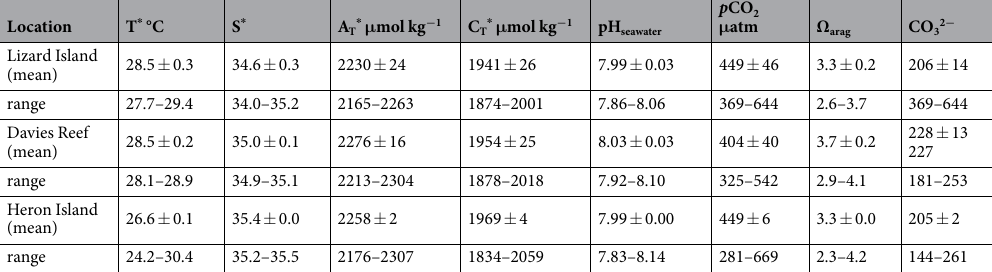
Table 2. Comparison of within-reef carbonate chemistry at Lizard Island (northern), Davies Reef (central) and Heron Island (southern) of the Great Barrier Reef. Values for Davies Reef and Heron Island determined by Albright et al . 33, 34 , respectively. Averages and ranges of measured * and calculated physical and chemical parameters given. Carbonate chemistry for Lizard Island was determined in this study in January 2014 on the back reef inside the Lizard Island lagoon (Fig. S1). Carbonate chemistry was determined on the back reef flat at Davies Reef in the summer January 2012. In Heron Island, values are for the combined sampling on the reef flat and crest in March 2012. T = temperature, S = salinity, A T = Total alkalinity, C T = Carbon total, p CO 2 = partial pressure of carbon dioxide, Ω arag = Aragonite saturation, CO 32 − = carbonate ion.